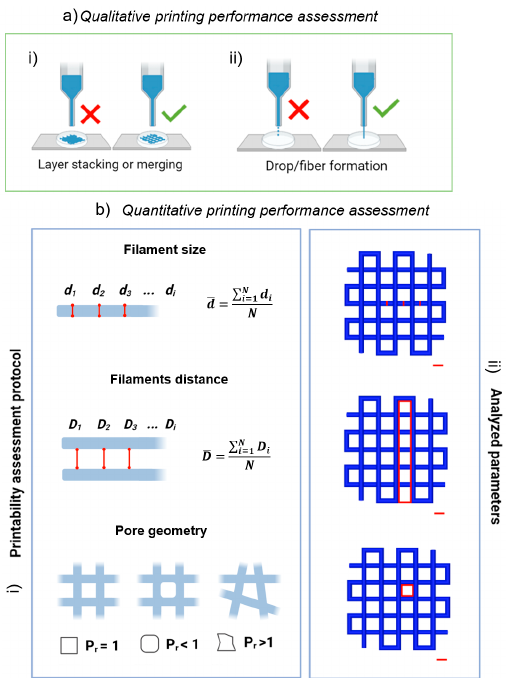
Figure 9. Assessment of printing performance. ( a ) Schematic representation of the proposed method to assess biomaterial ink’s qualitative printability. Initial screening of ink formulations to establish the ability to ( i ) produce grids with well-defined pores and ( ii ) fiber formation, as opposed to drop- let formation. ( b ) Schematic representation of the proposed method to assess biomaterial ink’s quan- titative printability. ( i ) Protocol for the assessment of printability and shape fidelity proposed by Schwab et al. [41]. ( ii ) Application of the protocol to our 3D virtual model. Scale bar 1 mm .